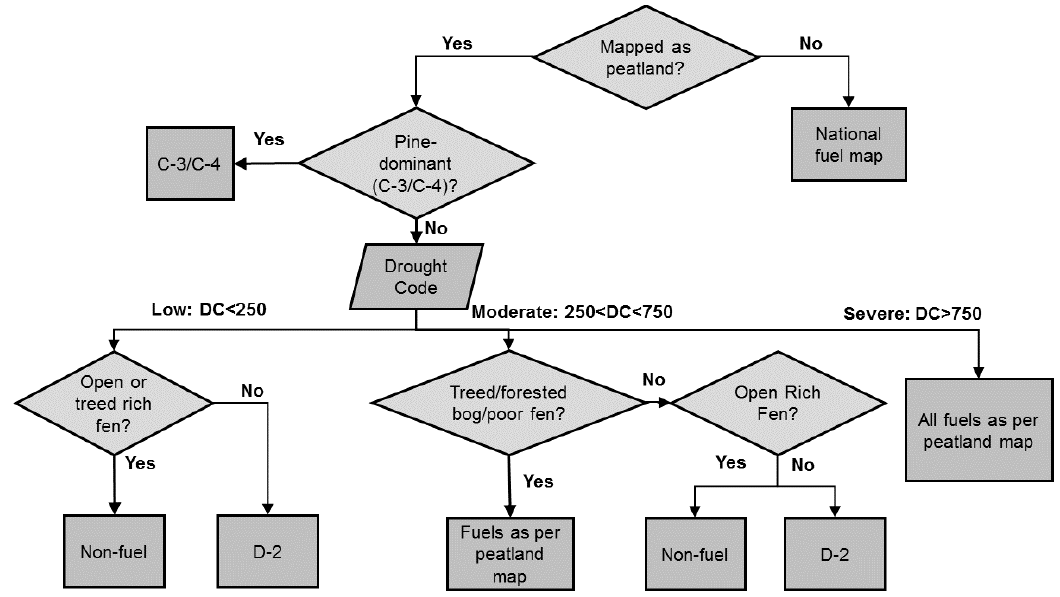
Figure A3. Flow chart summarizing the fuel mapping process based on upland fuels maps and the peatland type map and drought scenario. See Table 1 for complete description of the algorithm broken down by all peatland types and Drought Code levels. Table 2 for a comparison of potential fire behavior between fuel types and text description of fuel type (i.e. C–3 mature Jack or Lodgepole